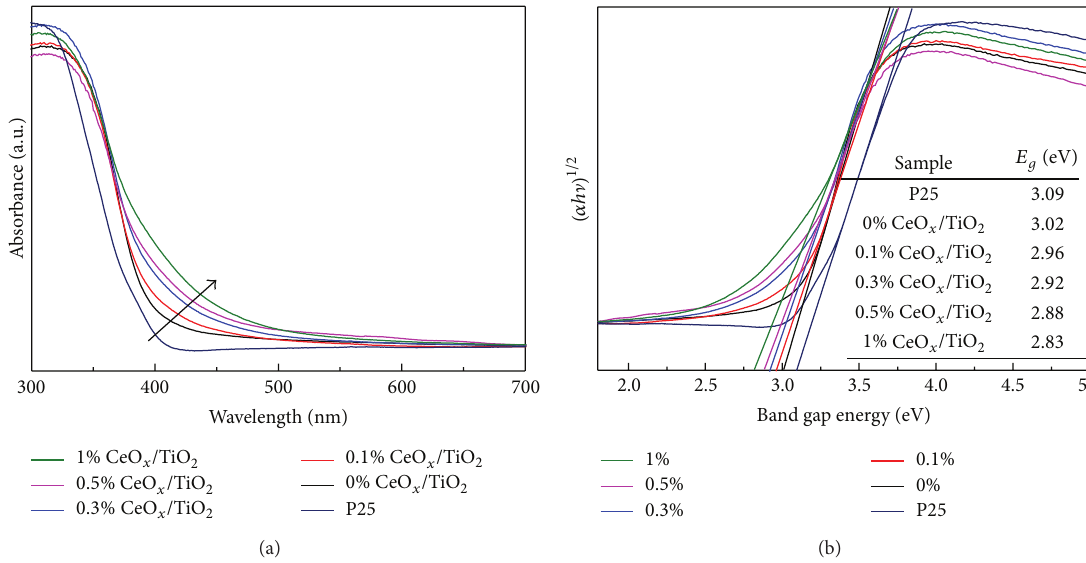
Figure 5: (a) UV-vis DRS of P25 and the 𝑥 % CeO 𝑥 /TiO 2 nanoparticles; (b) the plot of band gap energy and (𝛼ℎ ] ) 1/2 of P25 and CeO 𝑥 /TiO 2 nanoparticles.